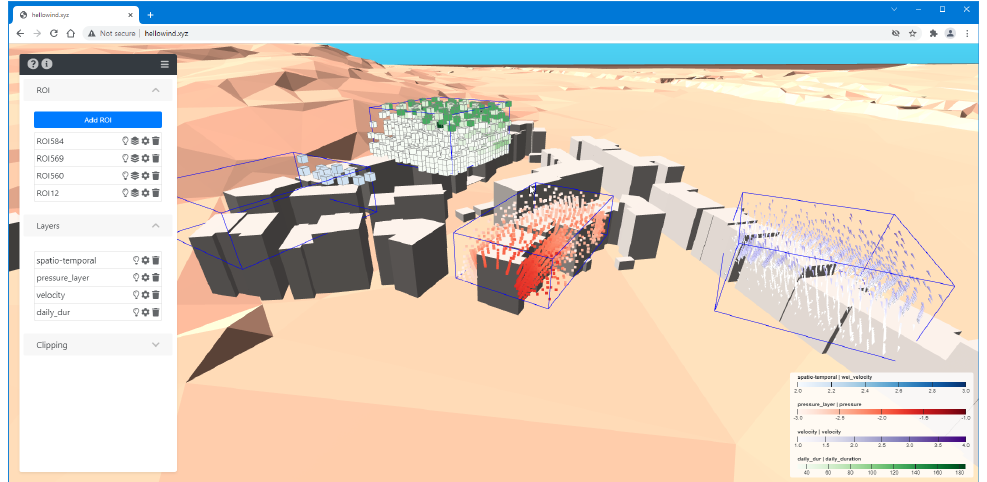
Figure 12. The web client user interface. Definition of four Regions of Interest in the case study area of Stöckach, Stuttgart. ROI from left to right: (ROI584) Spatio-temporal layer displaying locations of horizontal wind velocity above 3 m/s and daily duration above 30 min. (ROI12) Spatio-temporal layer displaying locations of horizontal wind velocity above 1.5 m/s and daily duration above 30 min. (ROI569) Spatial layer displaying pressure using point primitive. (ROI560) Spatial layer displaying velocity using vector